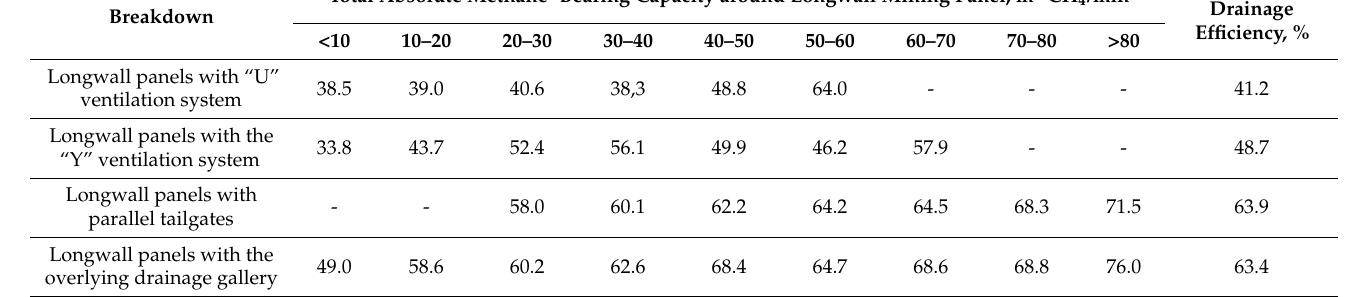
Table 4. The average efficiency of methane drainage of longwalls for used ventilation and methane drainage systems in the last years (following